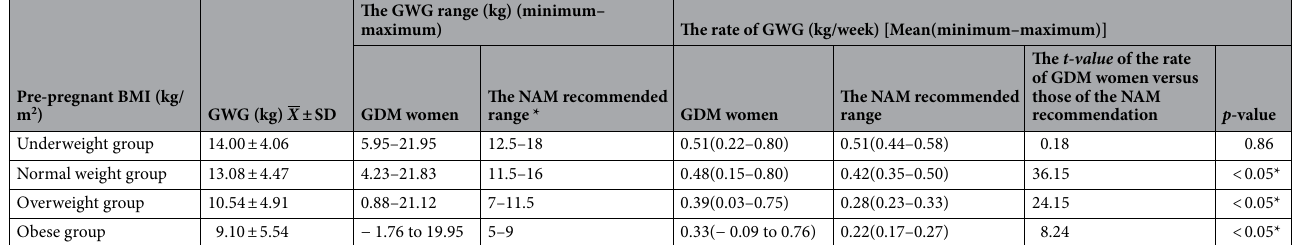
(Table 2). The GWG ranges and GWG rates in GDM women in different prepregnancy BMI subgroups were also tested. We found that Chinese women with GDM had different GWG ranges in the underweight, normal weight, over- weight and obese groups. The underweight GDM group had the narrowest GWG ranges (from 5.95 to 21.95 kg) (Table 2). Moreover, women in the underweight group had the fastest rate of GWG than the other groups (Fig. 1). The ranges of GWG in the normal weight and overweight groups were from 4.23 to 21.83 kg and from 0.88 to 21.12 kg, respectively. In contrast, GWG in the obese group had the widest GWG ranges (from − 1.76 to 19.95 kg)